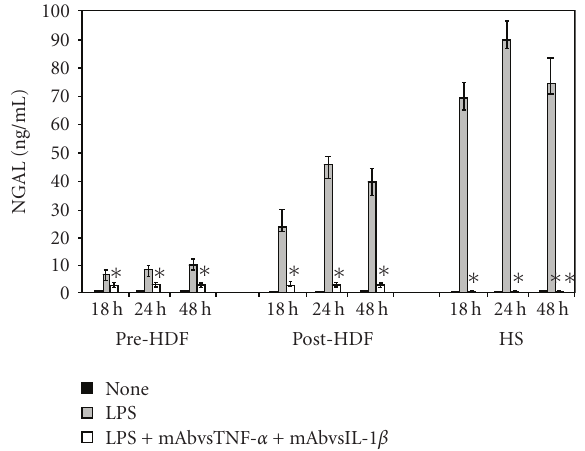
Figure 3: E ff ects of neutralization of IL-1 β and TNF- α on the kinetics of NGAL production by PMG from preHDF and postHDF patients and HS. ∗ Significantly di ff erent ( P < . 05) from that of LPS- stimulated PMG. ∗∗ Significantly di ff erent ( P < . 05) from that of LPS-stimulated